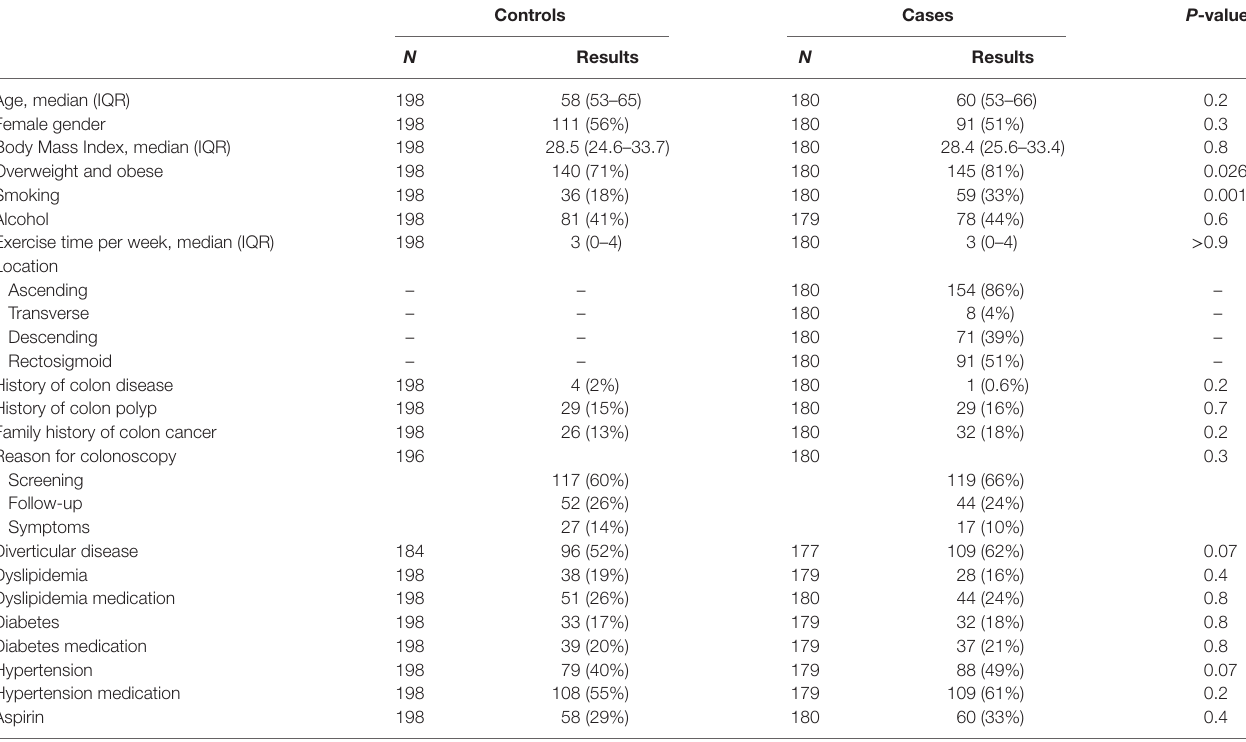
TaBle 1 | Distribution of demographic, clinical, and inflammatory markers in case and controls.